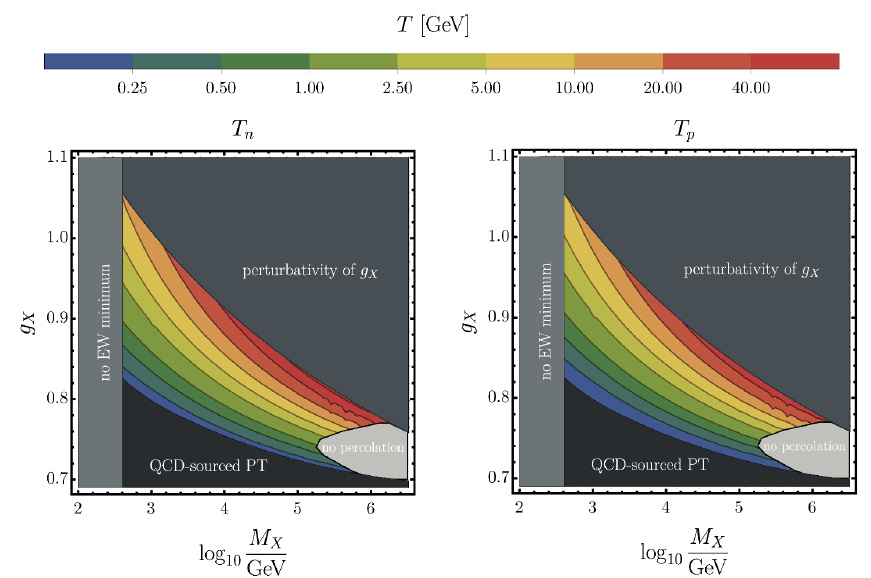
Figure 7 . The values of the nucleation temperature T n (left panel) and the percolation temperature T p (right